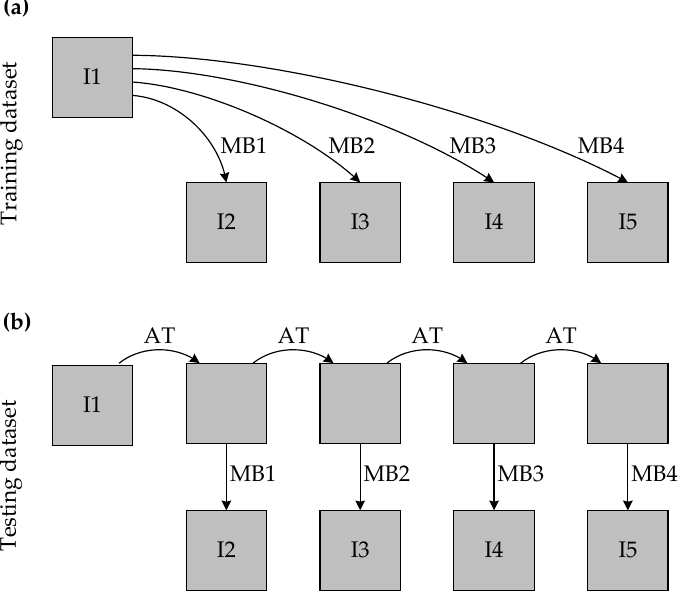
Figure 4. Construction of the training ( a ) and test ( b ) datasets by augmenting original image. Here I1—original image; I2, I3, I4, I5—augmented images; AT—affine transformation of the image; MB1– MB4—motion blurring from the lowest (#1) to the highest (#4)